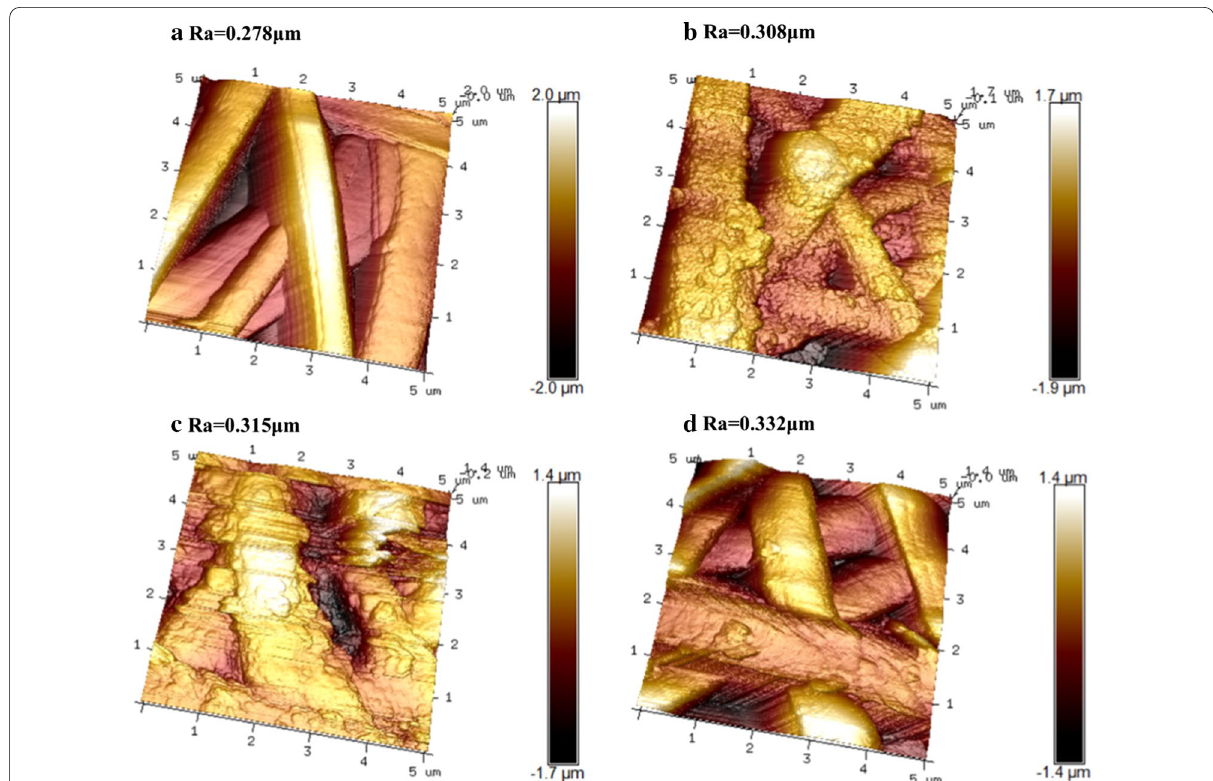
Fig. 4 AFM image and surface roughness (Ra) of a PLA nanofibers, b PANI/PLA-HA, c PANI/PLA-SA, and d PANI/PLA-PA composite